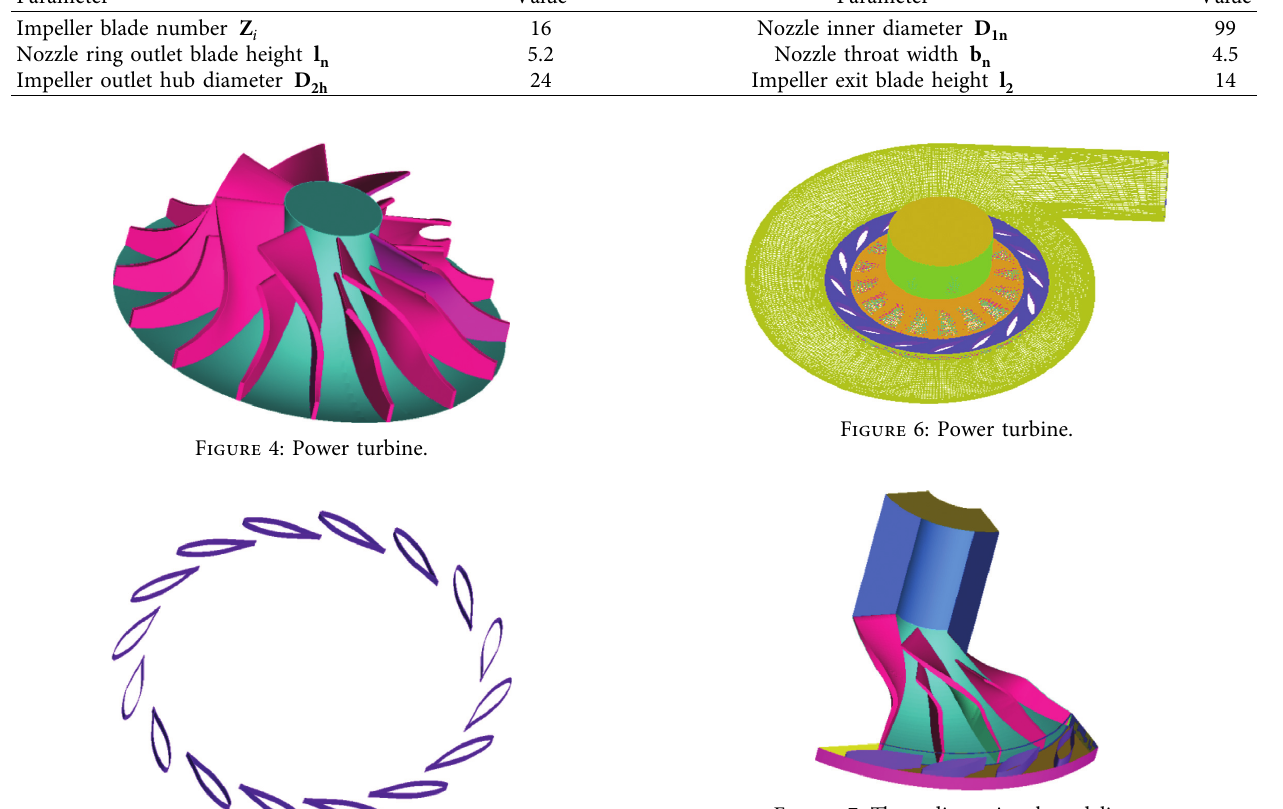
Figure 7: Three-dimensional modeling.